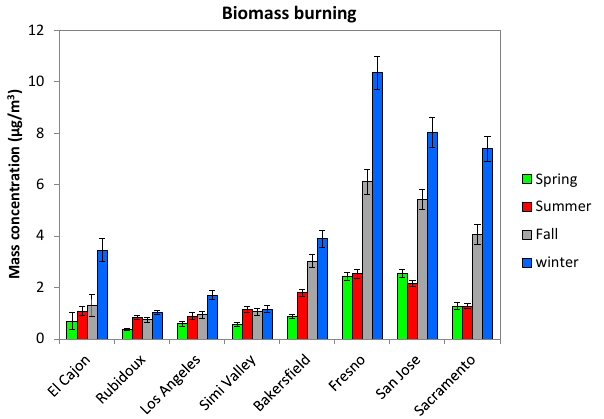
Figure 5. Seasonal average source contribution (µg/m 3 ) of biomass burning to ambient PM 2.5 , by site. Error bars correspond to one standard error.